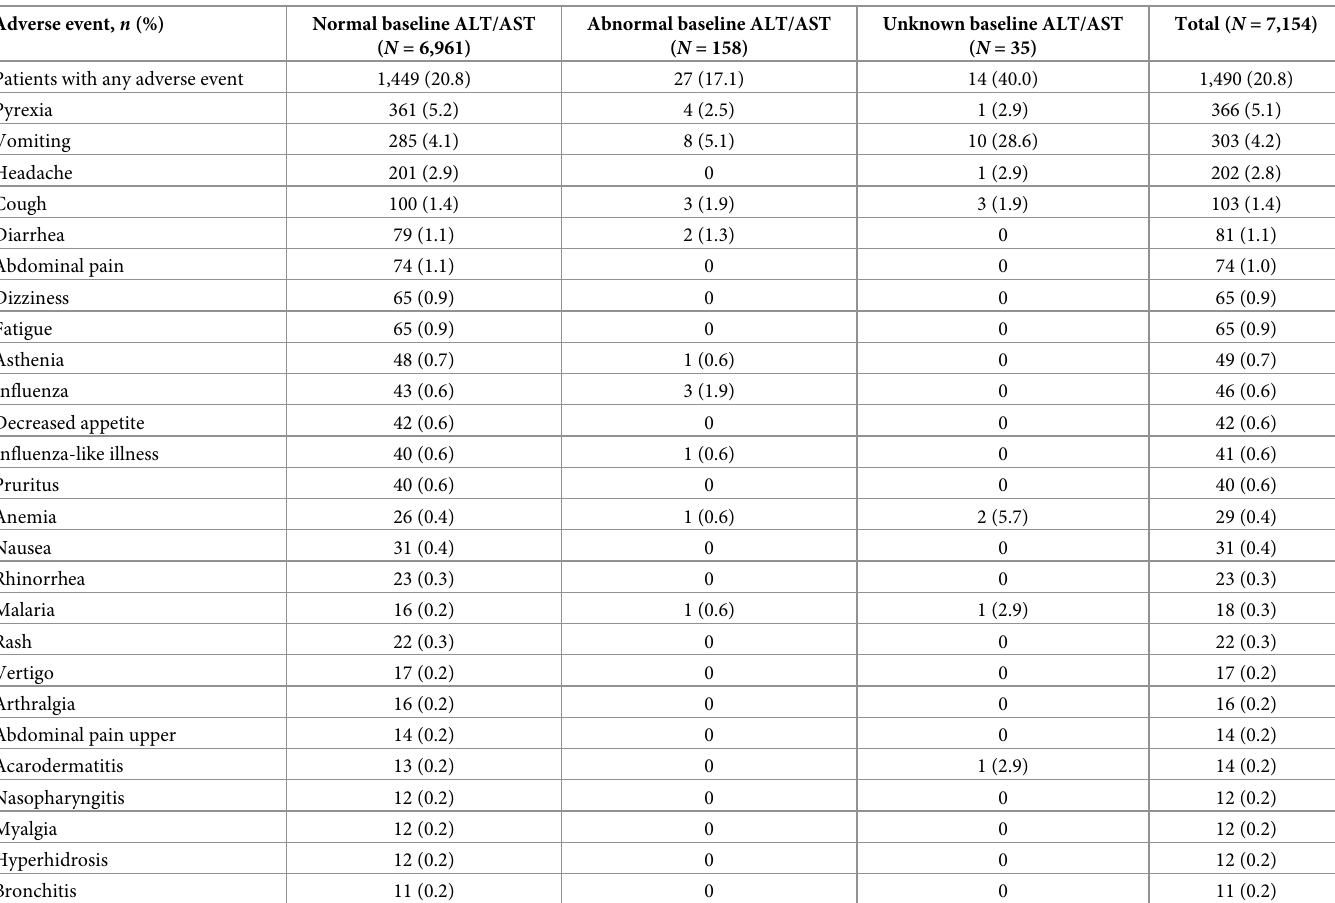
Table 2. Most common adverse events of any cause in patients treated with pyronaridine–artesunate for acute uncomplicated malaria (safety